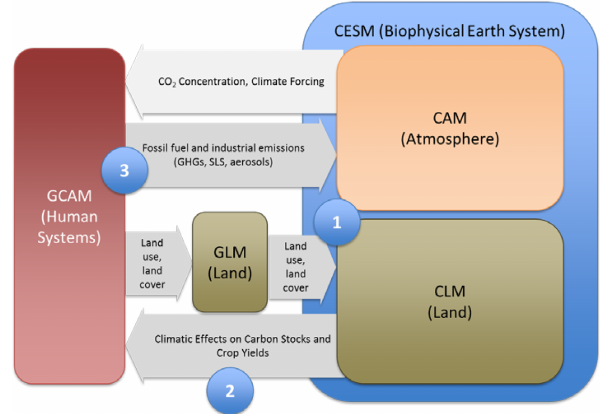
Figure 2. Schematic of the integrated Earth system model (iESM) showing its major component models GCAM, CESM, and GLM as well as the two-way connections between these